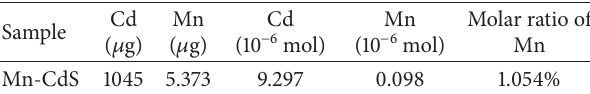
Table 2: ICP-OES test data of